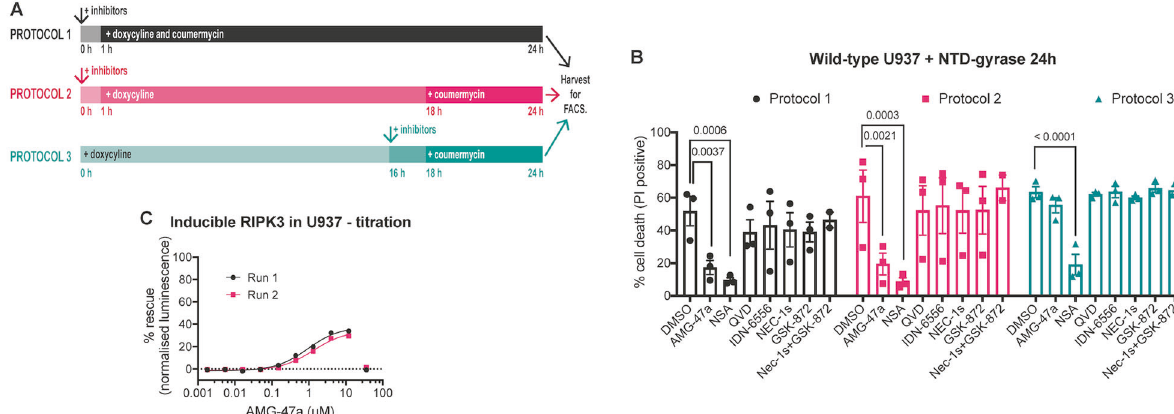
Fig. 5 AMG-47a inhibits necroptosis downstream of MLKL activation. A Three different experimental protocols were used to assess the ability of AMG-47a to inhibit cell death caused by the expression and dimerisation of the MLKL (1-180) -gyrase fusion protein. In protocol 1, inhibitors (or DMSO) were added fi rst, followed by doxycycline and coumermycin together, so that the fusion protein could dimerise on expression. In protocol 2, addition of coumermycin was delayed to allow levels of the fusion protein to accumulate before dimerisation was induced. In protocol 3, the addition of inhibitors (or DMSO) was also delayed, so that it was added after the fusion protein had been expressed for 16 h, but before the addition of coumermycin. In all experimental methods, cells were harvested 24 h after the experiment was initiated. represent three independent experiments; bars indicate the mean and error bars indicate standard error of the mean. Statistics were calculated in GraphPad Prism8, and p values are shown where <0.05. C Wild-type U937 cells with inducible human RIPK3 were treated with increasing doses of AMG-47a in the presence of 40 nM doxycycline, to induce expression, and 5 µM IDN-6556, to block caspase-dependent cell death. After 48 h, cells were harvested and viability assessed using the Cell-Titer Glo 2 (Promega) system. Data represent two independent experiments (four replicates per experiment) and have been normalised against doxycycline plus IDN-6556 (0% viability) and doxycycline plus IDN-6556 plus NSA (100%